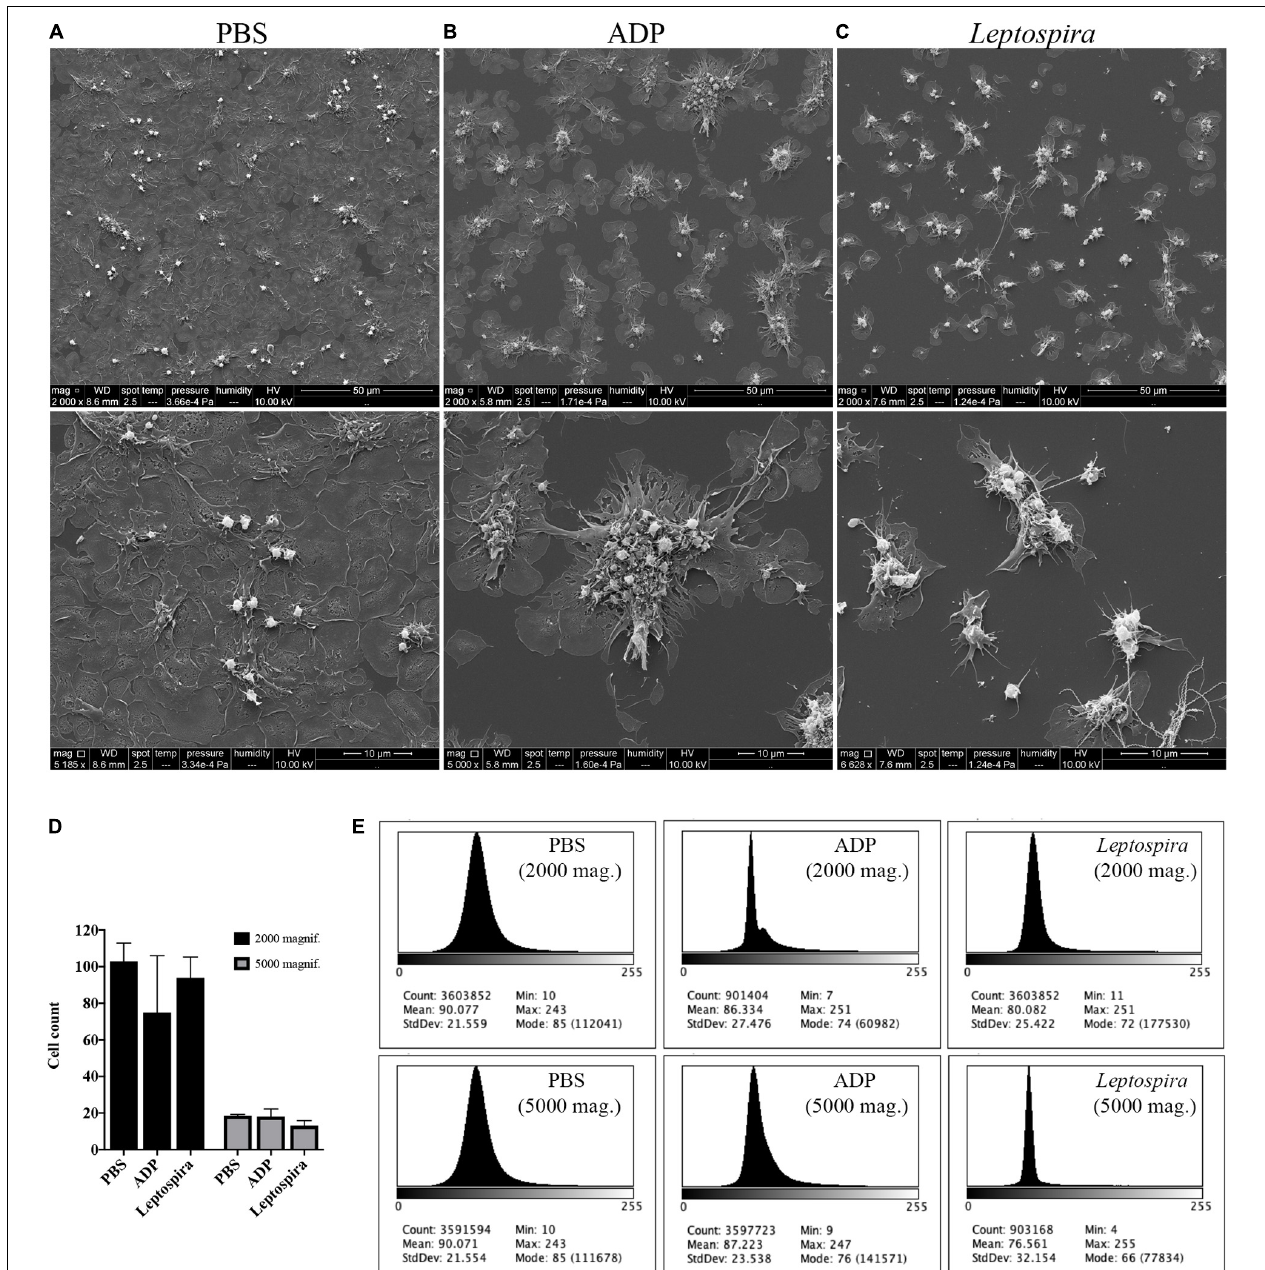
FIGURE 2 | SEM showing the effect of leptospires on pre-adhered platelets. Platelets from PRP were allowed to adhere to coverslip glass surfaces, washed, and treated with PBS (A) , ADP ( B ; positive control), or leptospires (C) for 30 min. After washing and fixation, samples were prepared for scanning electron microscopy. Upper panel: 2,000 magnification. Lower panel: 5,000 magnification. The figure shows representative panels of the samples. Two independent experiments were performed, with similar results. (D) Cell count of resting or dendritic platelets observed as individual cells in SEM images. The bars represent the mean ± standard deviation of two independent experiments. (E) Gray-scale histograms of the representative images, as analyzed by the software ImageJ.